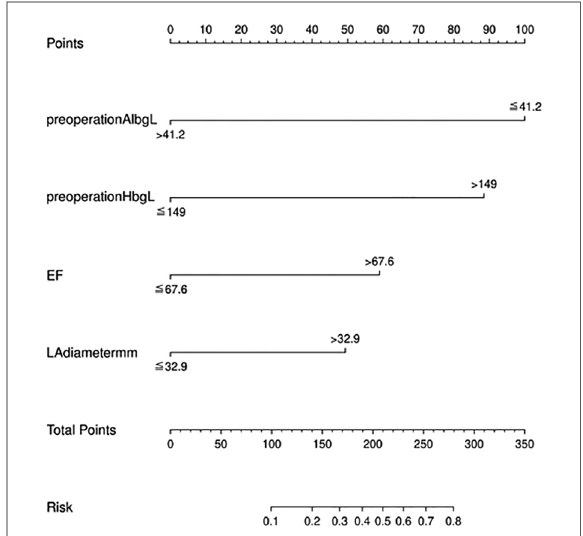
FIGURE 3 Thenomogrammodeltopredictpostoperativeatrial fi brillationamong patients receiving neoadjuvant therapy and minimally invasive